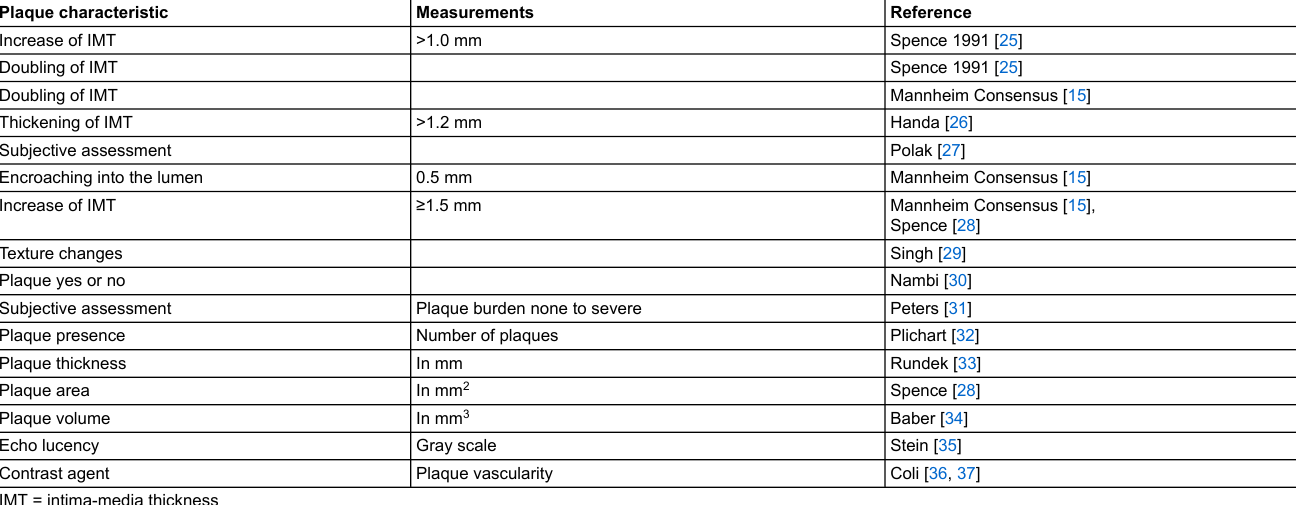
Table 1: Parameters frequently used for the quantification of carotid plaques.